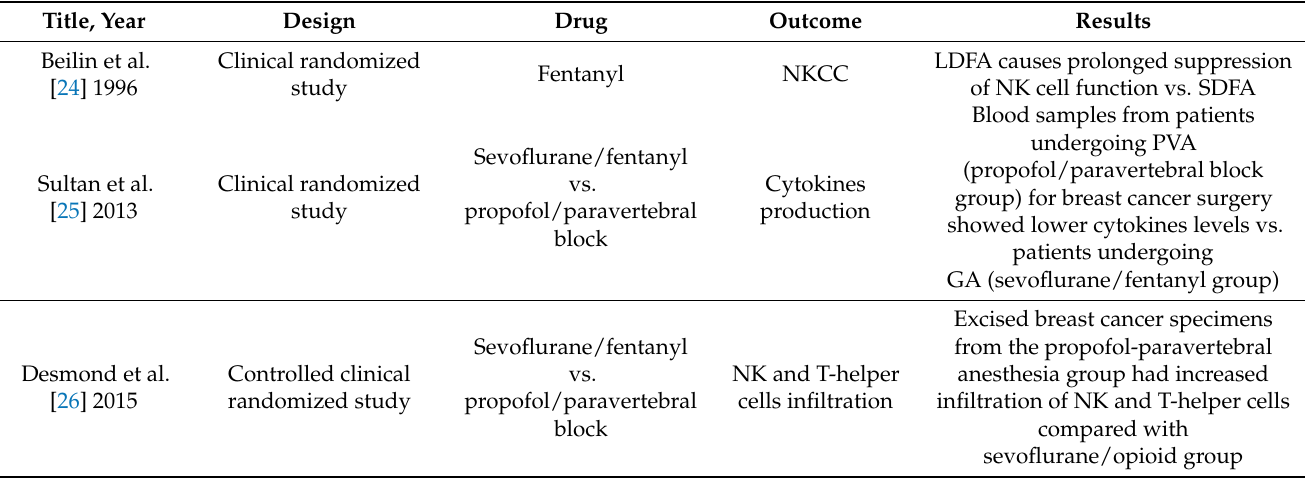
Table 2. Opioids and immune system. Selected randomized clinical studies. LDFA: Large-dose fentanyl anesthesia; SDFA: small-dose fentanyl anesthesia; GA: general